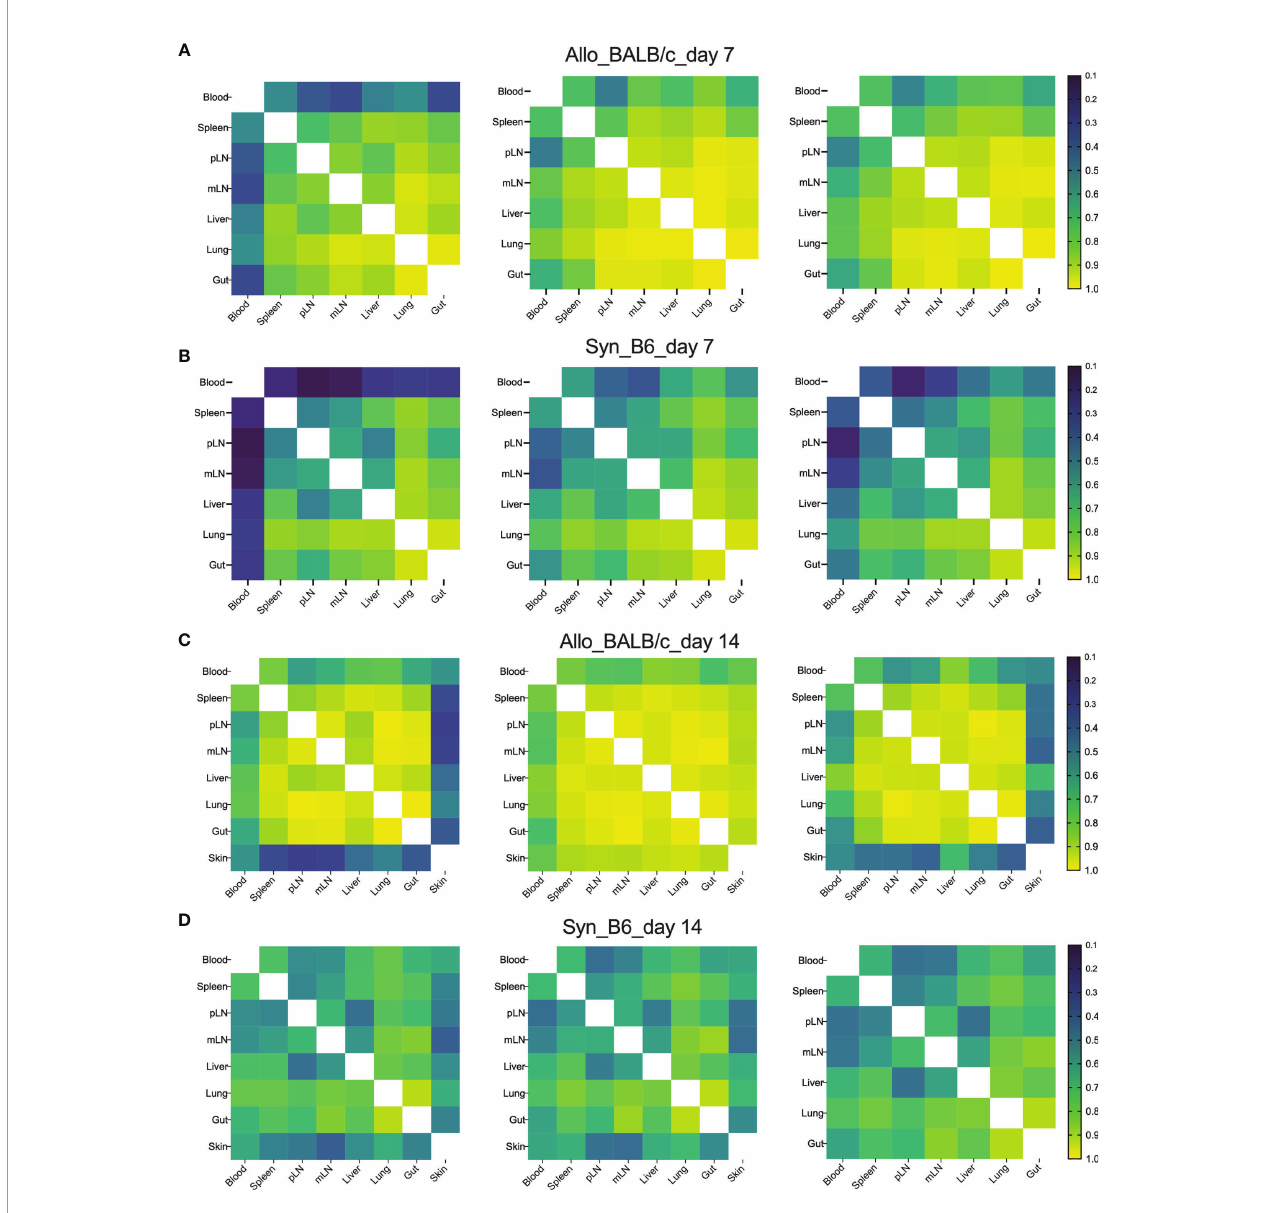
FIGURE 2 | High clone sharing by different tissue sites in allogeneic recipients. Sample overlap was computed by averaging across the two ratios of shared reads over total reads for each sample. Heatmap shows the overlap metric across different tissue sites in an individual recipient on day 7 (A, B) and day 14 (C, D) after